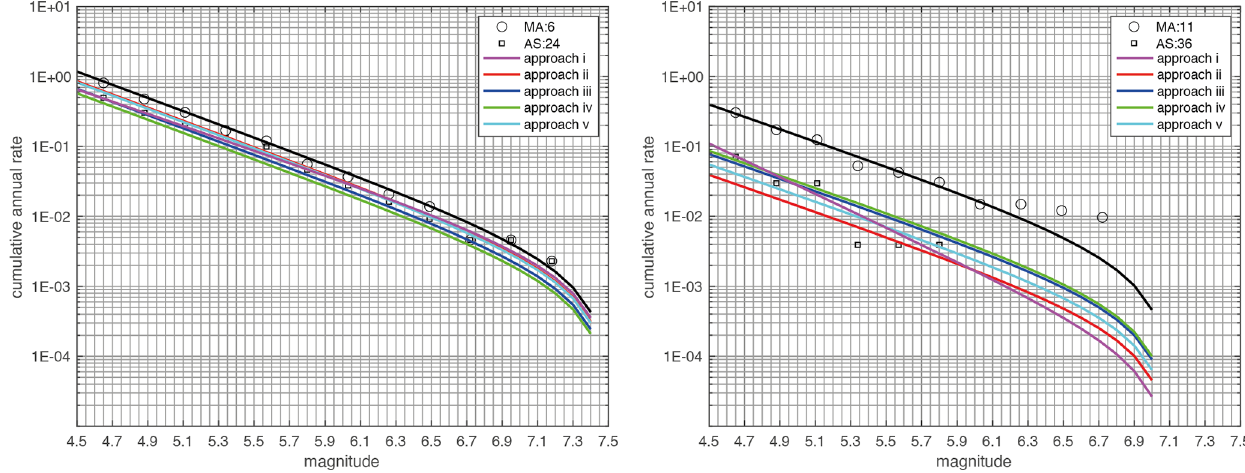
Figure 7. Example of the frequency–magnitude distributions calculated for area source (AS) nos. 24 and 36. The frequency–magnitude distributions of the macroarea (MA) they belong to are also shown. The area source and the macroarea are shown in Fig. 5b.